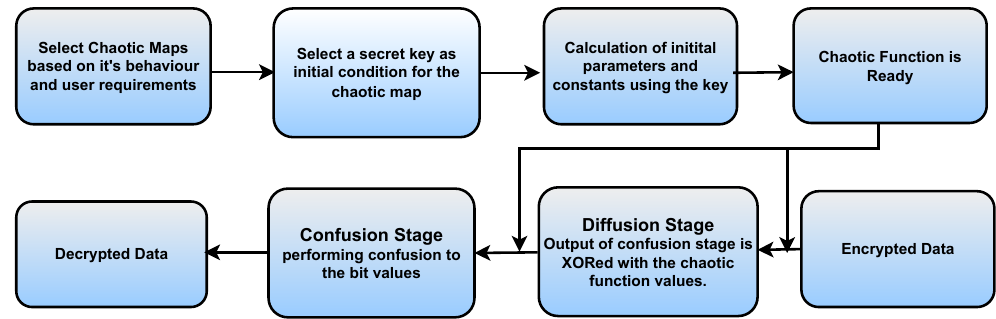
Figure 3. A simple Chaotic Map-based